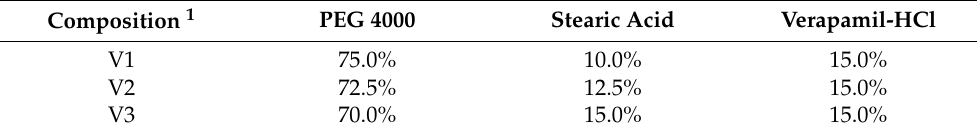
Table 1. The composition of the capsules prepared by the continuous foaming process.